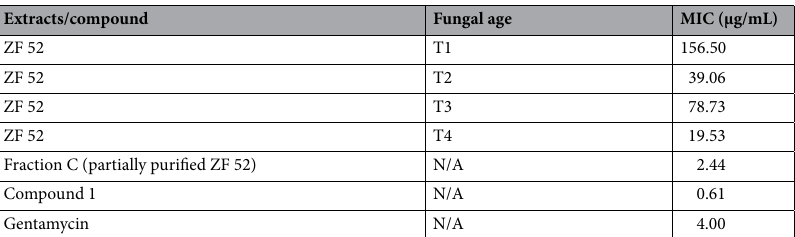
Table 1. Minimum inhibitory concentrations (MICs) of ZF 52 crude and semi purified extracts and compound 1 (3a,10b-dimethyl-1,2,3,3a,5a,7,10b,10c-octahydro-5,8-dioxa-acephenanthrylene-4,9-dione) against P. aeruginosa . Gentamycin served as the positive control. T1, T2, T3, and T4 represent weeks 1, 2, 3 and 4, respectively in the fungal culture period. N/A = not applicable.